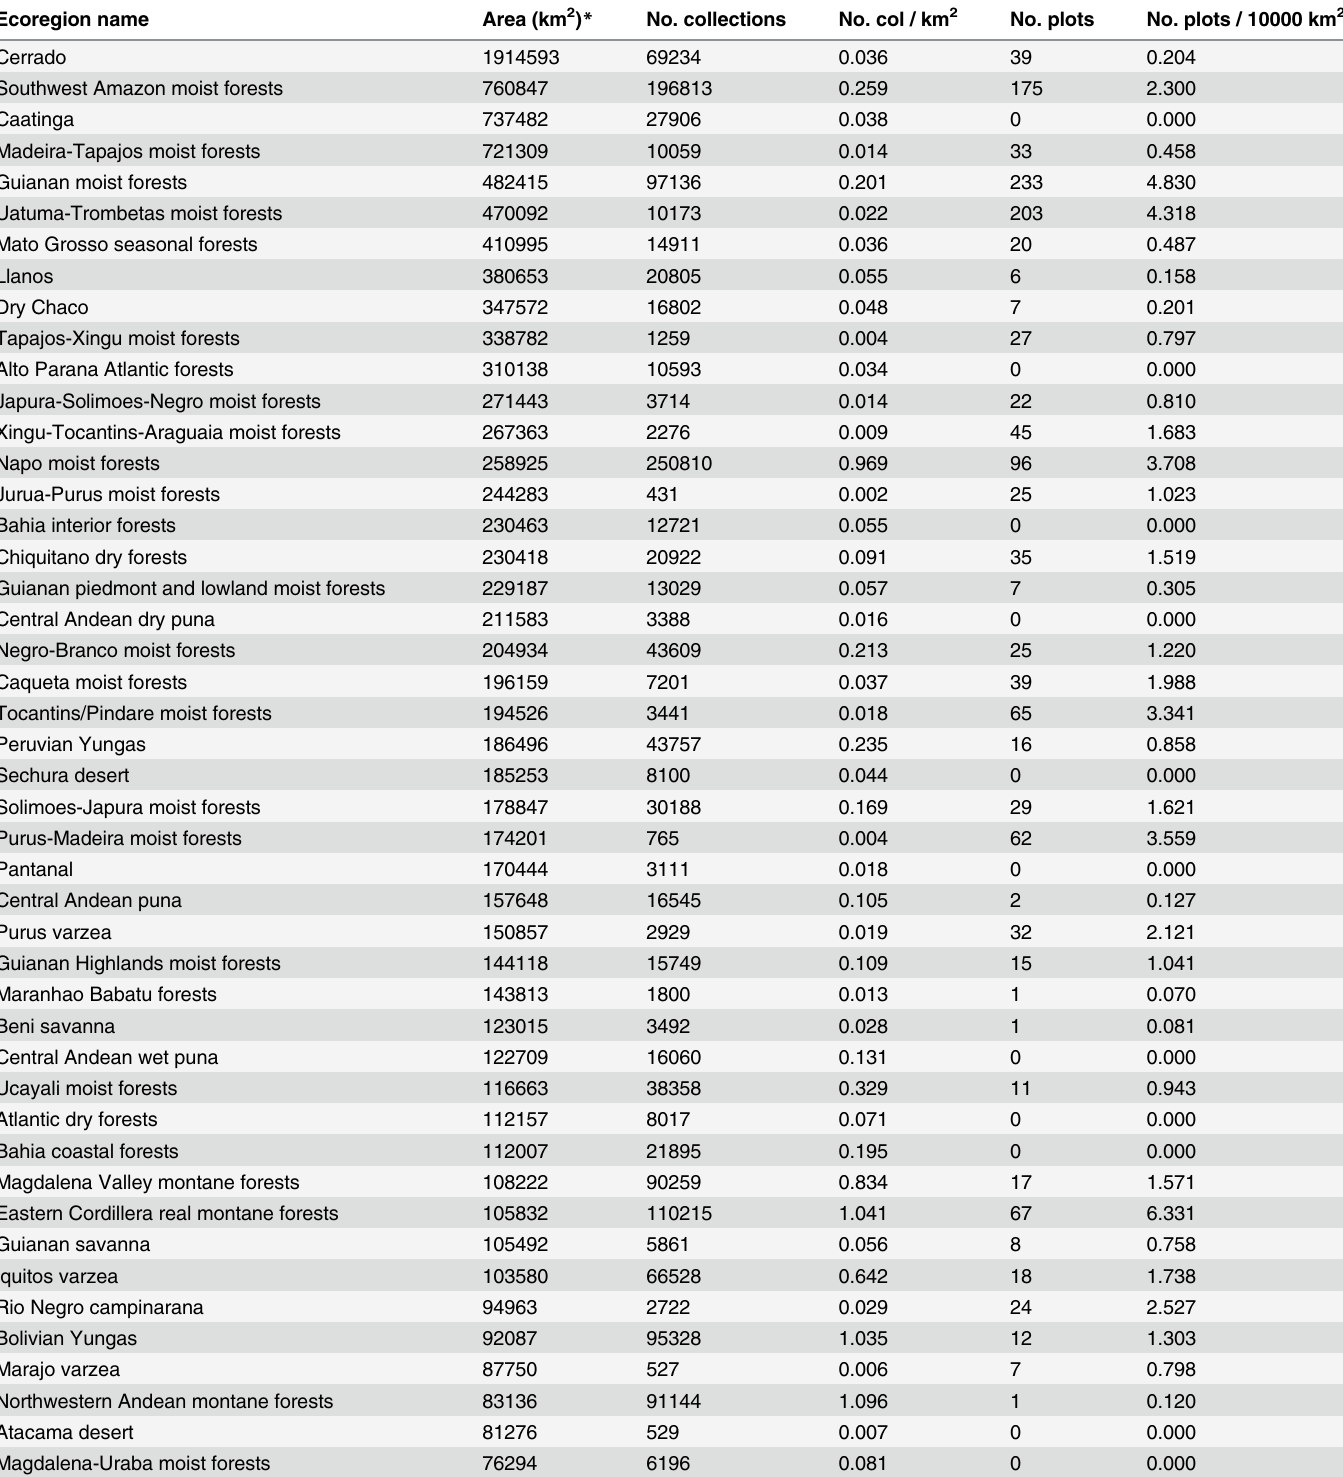
Table 2. Density of collections data and census plots in different ecoregions of tropical South America (ecoregions defined according to the World Wildlife Fund; http://www.worldwildlife.org/publications/terrestrial-ecoregions-of-the-world;